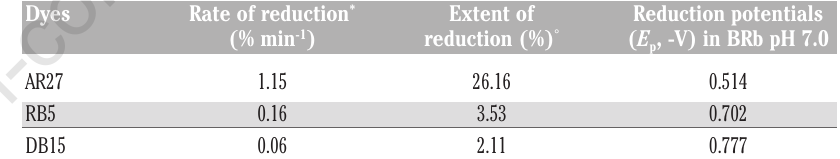
Table 1. Summary of the reduction data of the azo dyes by Fre, and the reduction poten- tials determined using voltammetry.